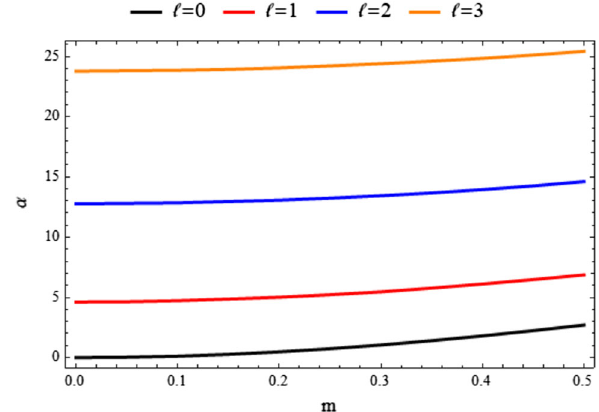
(cid:4) , m and (cid:2) , by imposing smoothness for the scalar filed at the horizons, one can select a discrete set of α/ M 2 , which give a discrete set scalar field profile characterized by different nodes k in between the two horizons. Those selected α/ M 2 could be known as bifurcation points at which SdS black